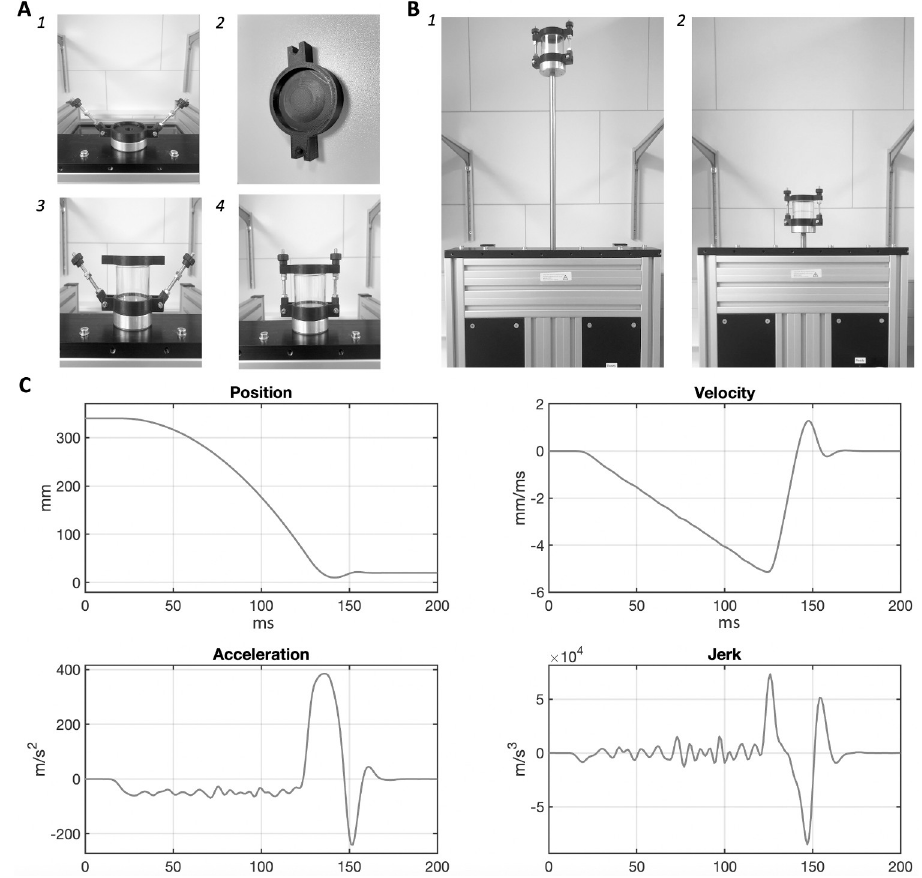
Fig 1. Concussion procedure. (A) Illustration of the mounting of the cylindrical capsule (containing fish in water) on the holder, following the numerical order of the panels. The capsule’s black lid was provided, on its side exposed to water, of a convex rounded protuberance of smaller diameter than the cylindrical capsule (2). This shape allowed any air contained in the capsule to be expelled by pressure when the lid was placed on top of the capsule (containing fish in water). The lid-covered capsule was placed on the holder, which had a cylindrical cavity (size-matching the capsule’s diameter) that prevented the capsule from moving side-wise (A1-A3). The screws on the sides were then used to securely lock the capsule (3,4). (B) Illustration of the movement performed by the motor: the capsule is slowly brought up to the start position (B1) and rapidly slides down to the end position (B2) with the parameters described in the following panels. (C) Features of the linear movement plotted as a function of time (ms): position, velocity, acceleration and jerk. https://doi.org/10.1371/journal.pone.0268901.g001 C1250-LU-XC-OS-000. The input was created using an inbuilt software library (Create Curve, Limited Jerk), which designed the motion curve based on the desired limit parameters: start point (+/-mm) and end point (+/-mm) relative to the home position, maximal velocity (m/s), maximal acceleration (m/s 2 ), maximal deceleration (m/s 2 ) and maximal jerk (m/s 3 ). It was thereby obtained a motion curve with the following features: duration (~121 ms), length (320 mm), peak velocity (~5.1 m/s 2 ), peak (initial) acceleration (~61 m/s 2 ), peak deceleration (~385 m/s 2 ), illustrated in Fig 1C. Several pilot-runs with small samples were run–before this study– to ensure that the motion curve would not cause the death of the fish within 48h in at least 90% cases. The software was provided with a built-in digital oscilloscope that could obtain a readout of a motion curve being performed, stored as csv-file. The oscilloscope was used to ensure the reliability of the apparatus in repeated executions of the same motion curve. The triggering input commands in the software (home & start) were connected, for convenience,